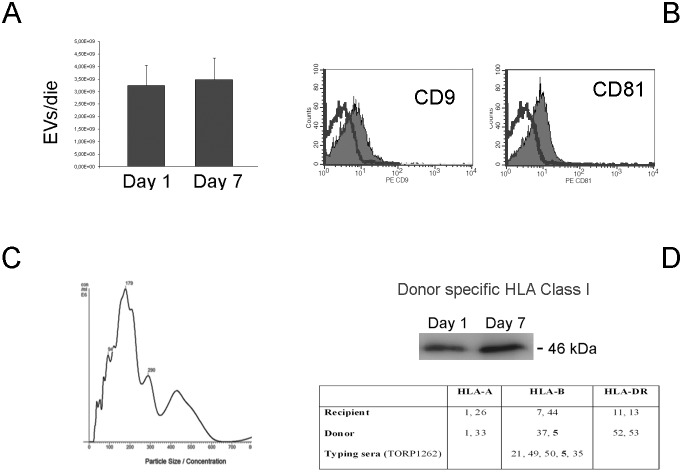
Characterization of urinary EVs in transplanted patients.Urinary EVs were obtained from patients (n = 25) undergoing renal transplant. Panel A. Mean number of EVs/day in the urine of transplanted patients were similar at day 1 and 7 after transplant, counted as described in Material and Methods. Data are mean ± SD of all samples. Panel B and C. Characterization of EVs showing expression of CD9 and CD81 exosome markers and NanoSight analysis of size distribution profile. Similar results were obtained for samples from all transplanted patients at day 1 and 7. Panel D. Representative western blot analysis showing the donor origin of the extracellular vesicle using typing sera containing antibodies directed against HLA class I antigens of the donor not shared by the recipient, at 1 and 7 days after transplant. In the table are reported the HLA typing of the recipient and the donor and the HLA-antigen recognized by the typing serum (TORP1262). HLA-B5 (bold) is present in the donor and not in the recipient. Three patients were tested with similar results.